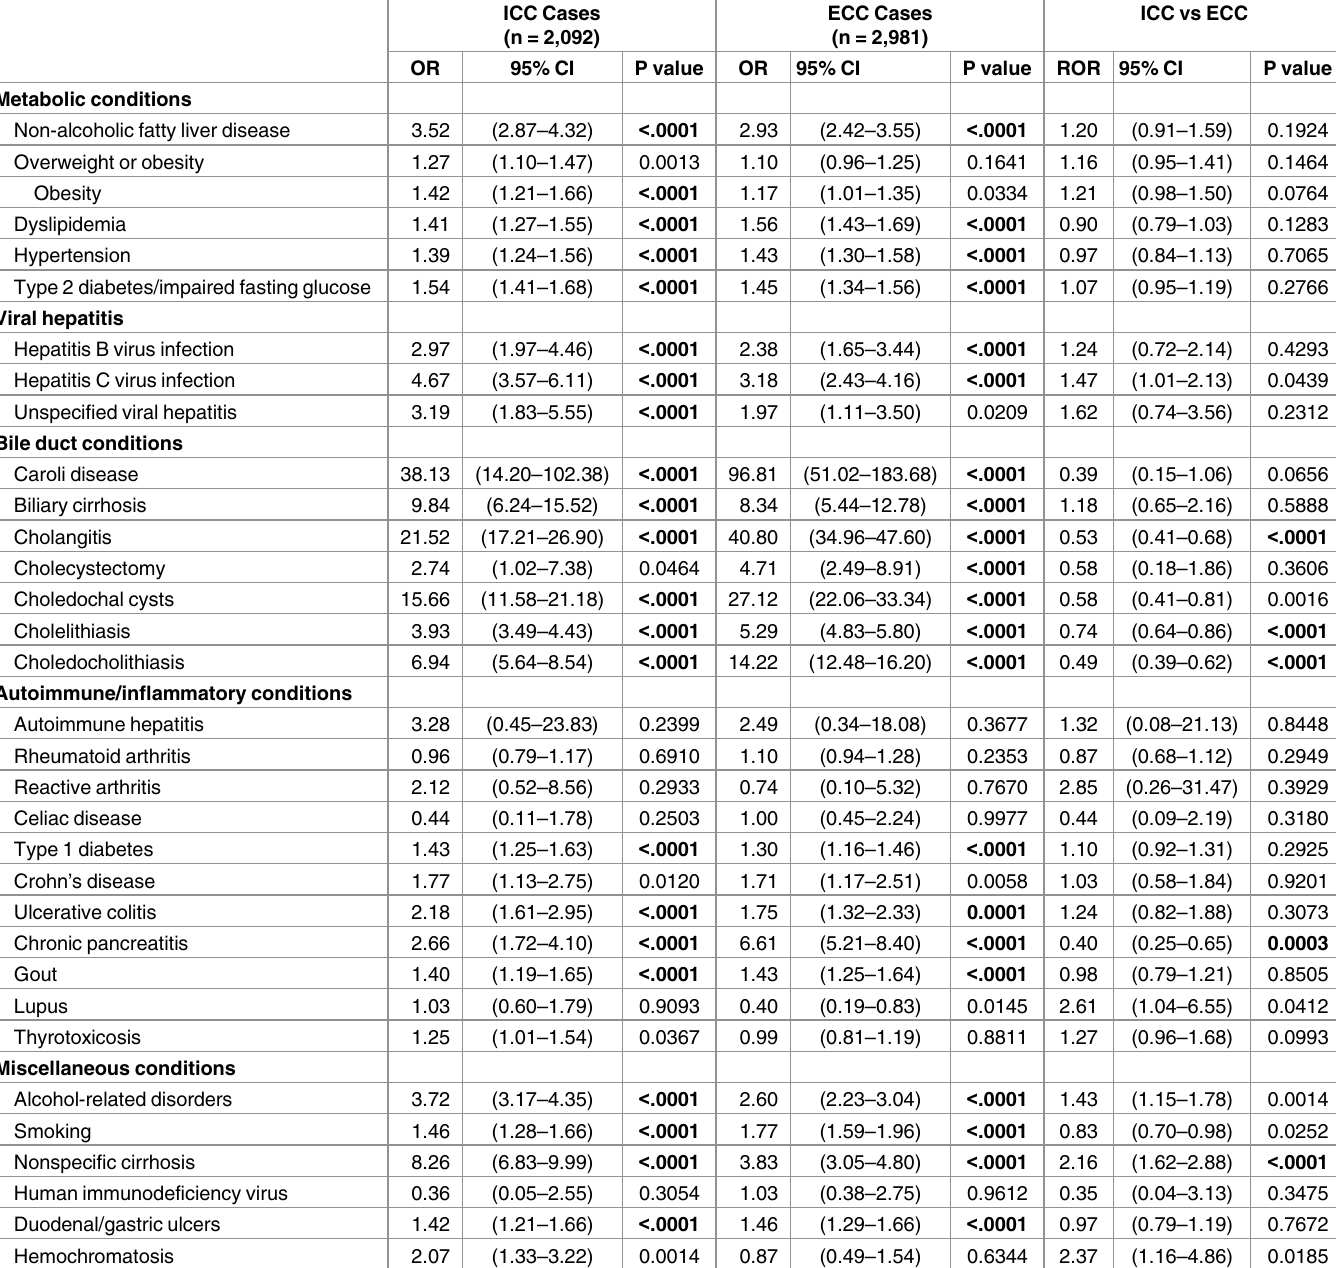
Table 4. Adjusted 1 logistic regression analysis examining the association between selected medical conditions and ICC or ECC, SEER-Medicare